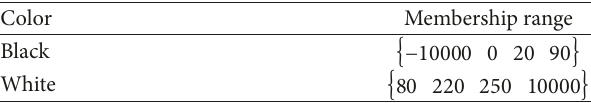
Table 1: Initial membership functions for inputs.